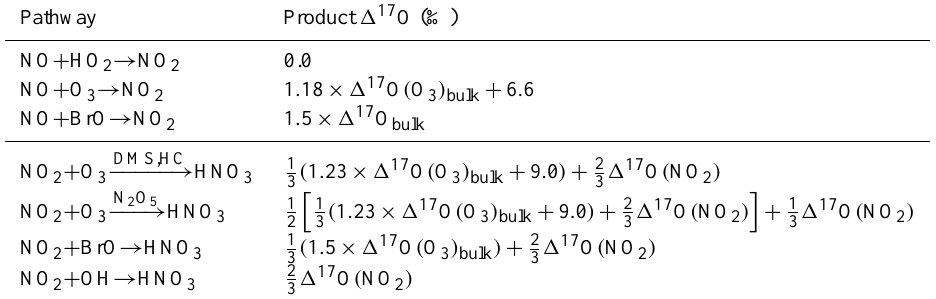
Table 3. Nitrate model isotope assumptions.